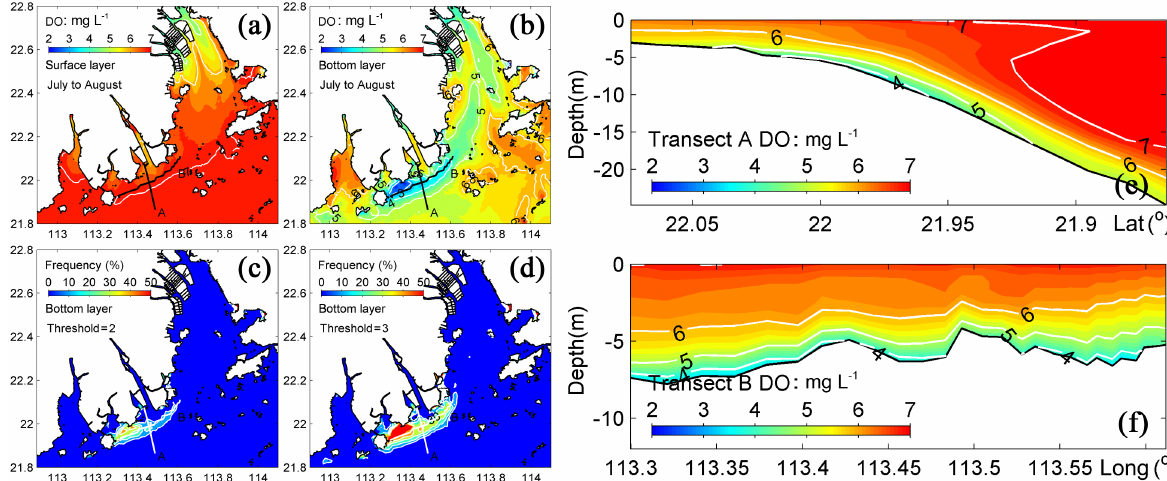
Figure 10. Spatial distributions of the monthly averaged DO concentrations at (a) the surface layer and (b) the bottom layer in the PRE. Spatial distributions of hypoxic frequency during July and August using DO thresholds of (c) 2mgL − 1 and (d) 3mgL − 1 for hypoxia. Vertical distributions of the DO concentrations along two transects (see their locations in a–d